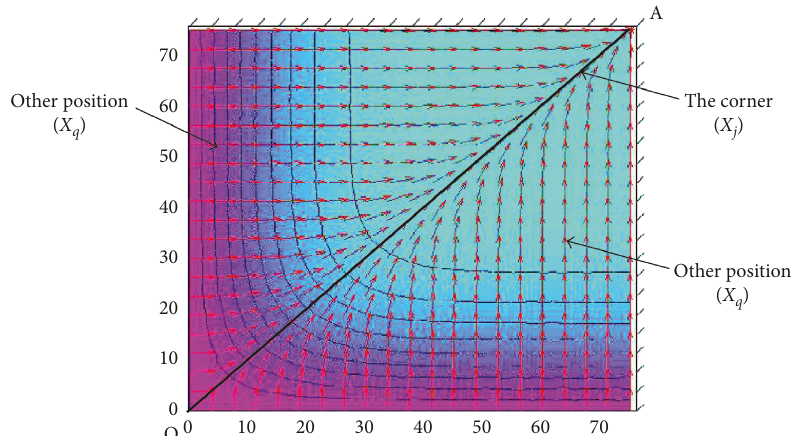
Figure 6: Simulation process at the carbonation